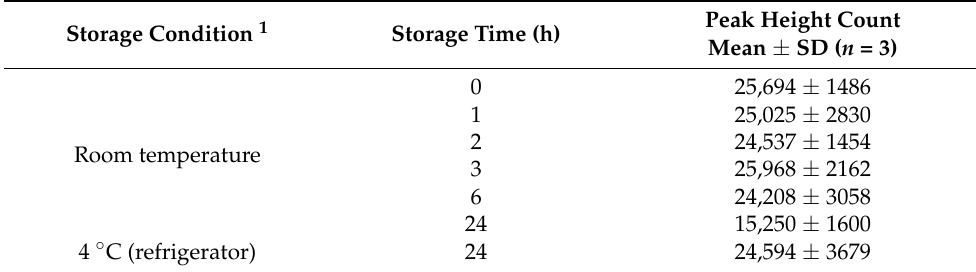
Table 2. Comparison of storage conditions after sampling by the wiping method.